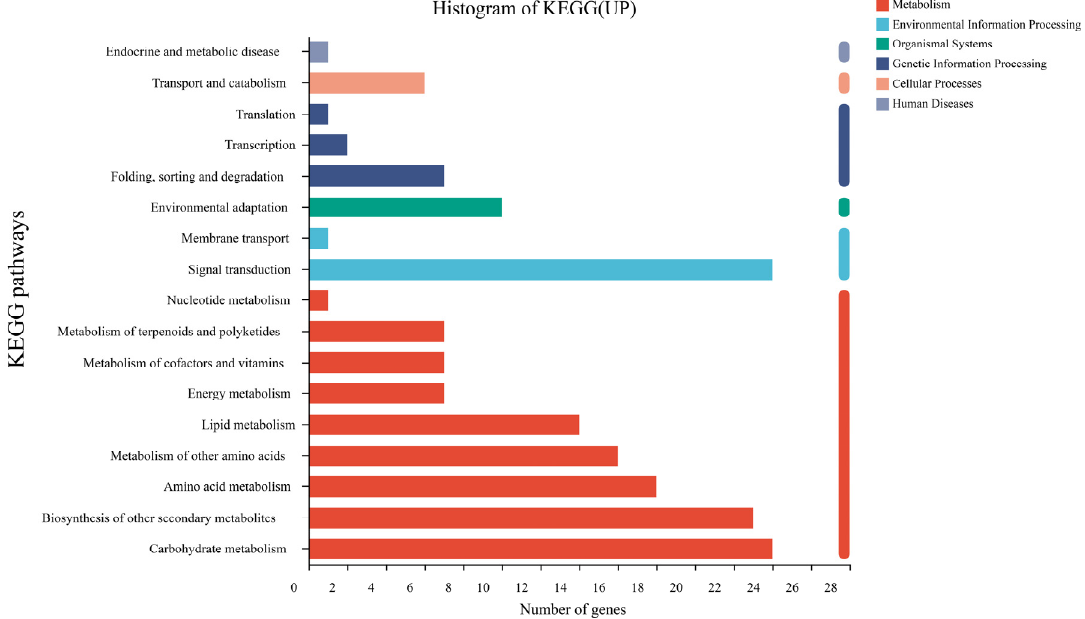
Figure 8. Key function annotation of upregulated KEGG pathway genes between the G20 (noninoc- ulation) and G20S (strain SR-9 inoculation) treatments.